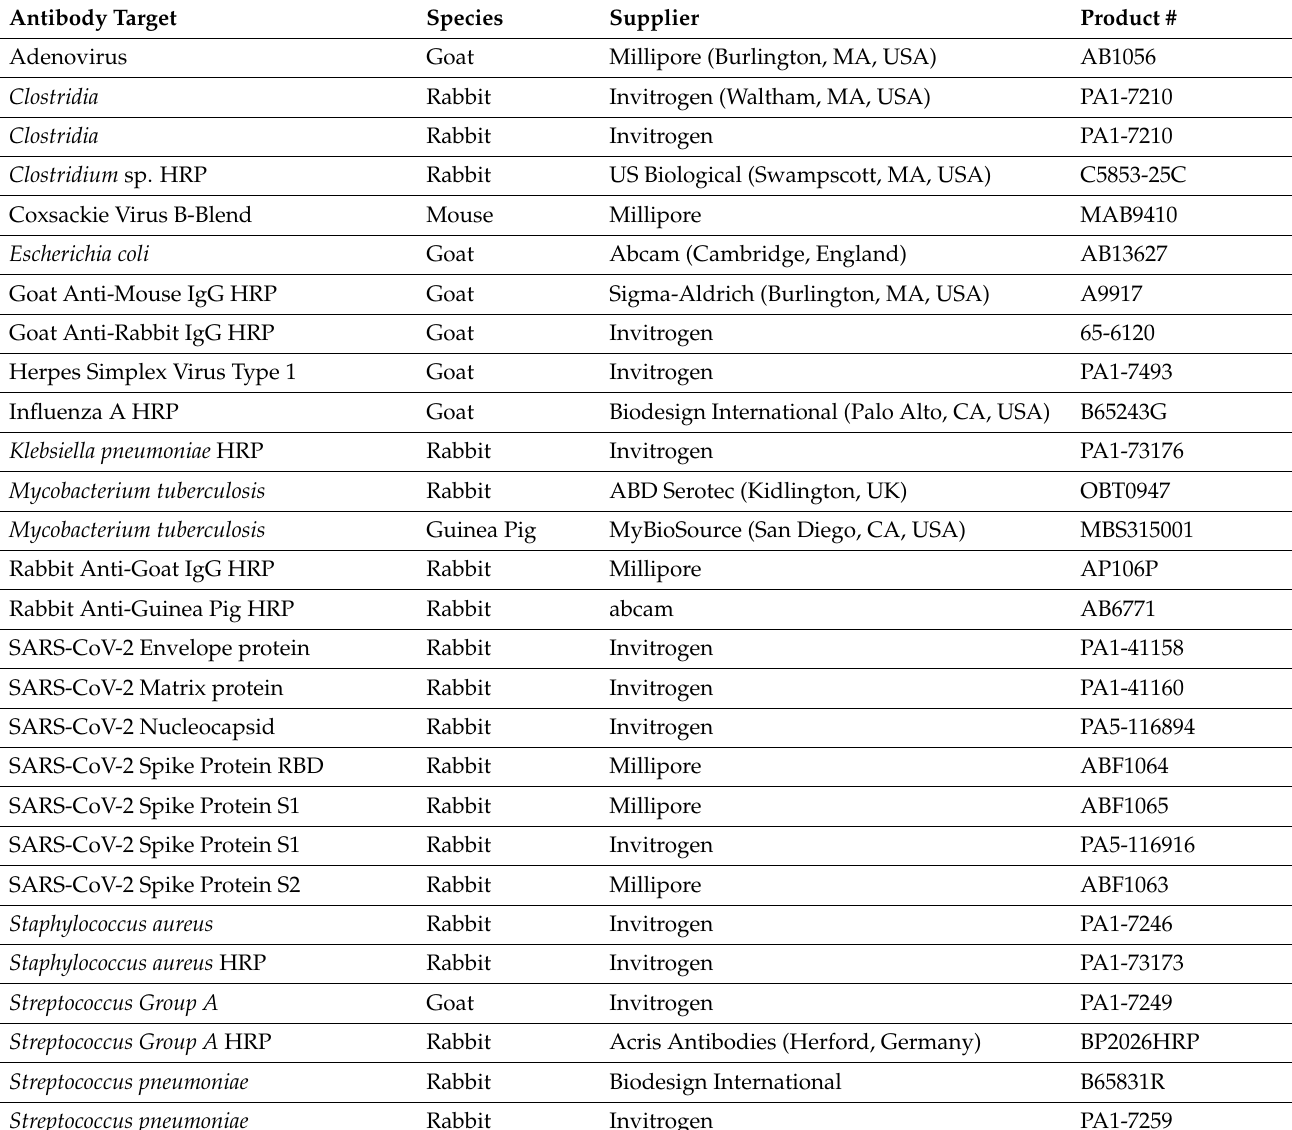
Table 3. Antibodies utilized in this